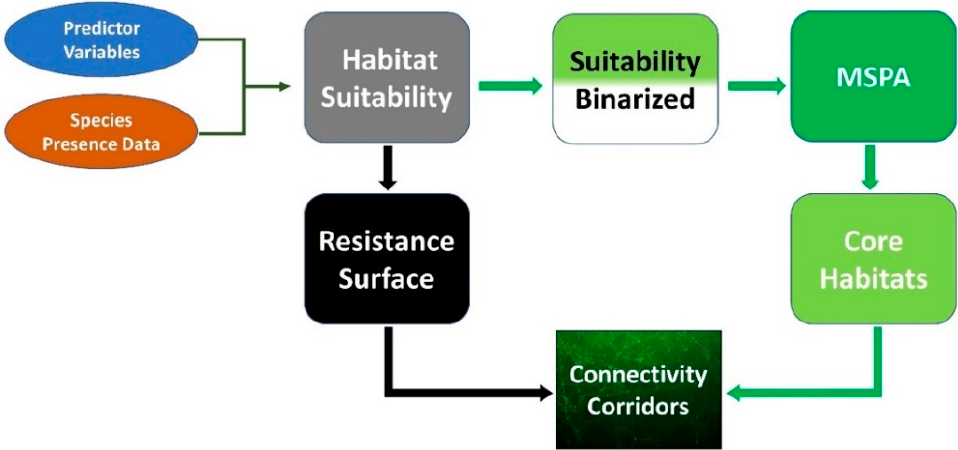
Figure 2. Basic workflow of the analyses for identifying the primary (core) habitats, estimating connectivity metrics, and mapping the potential functional corridors. Species presence data and predictor variables were used to model the suitable habitats, which were in turn used to derive the resistance surface and the core habitats. Finally, the core habitats and the resistance surface were used to design the dispersal corridors and estimate connectivity among the different core habitats. MSPA refers to Morphological Spatial Pattern